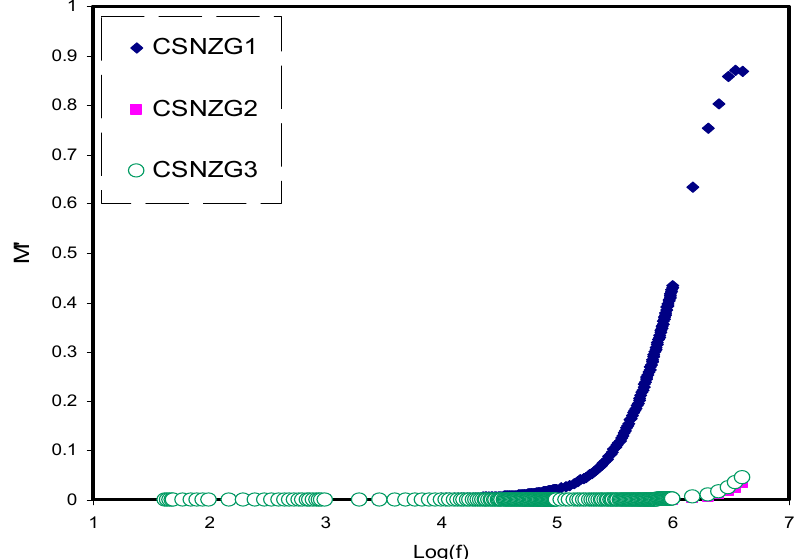
Figure 7. Variation M ʹ along with frequency for the CSNZG1, CSNZG2, and CSNZG3 composite electrolyte samples at ambient temperature.